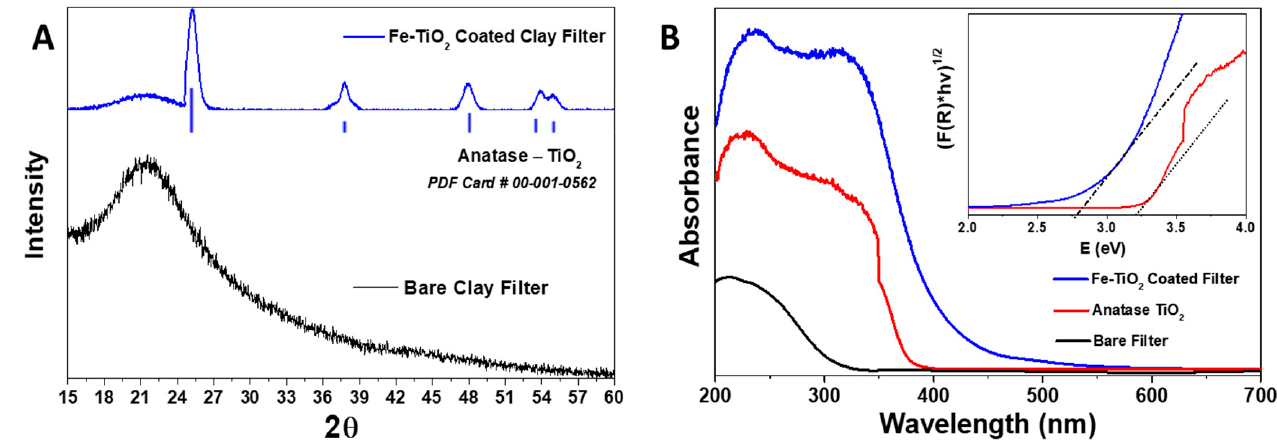
Figure 1. ( A ) XRD patterns of bare and Fe-TiO 2 -coated clay filters and ( B ) UV/Vis DRS spectra of bare and Fe-TiO 2 -coated clay filter and anatase TiO 2 (without Fe); inset, Tauc plot of the coated filter and anatase TiO 2 (without Fe) with an estimated energy band gap.